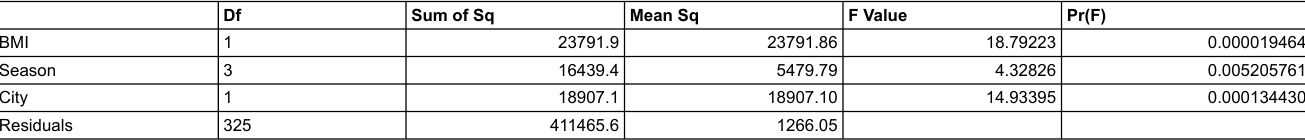
Table S2: Outcome serum 25-hydroxyvitamin D (nmol/l) at first visit: body mass index, season and city as predictors (type III sum of squares). Df Sum of Sq